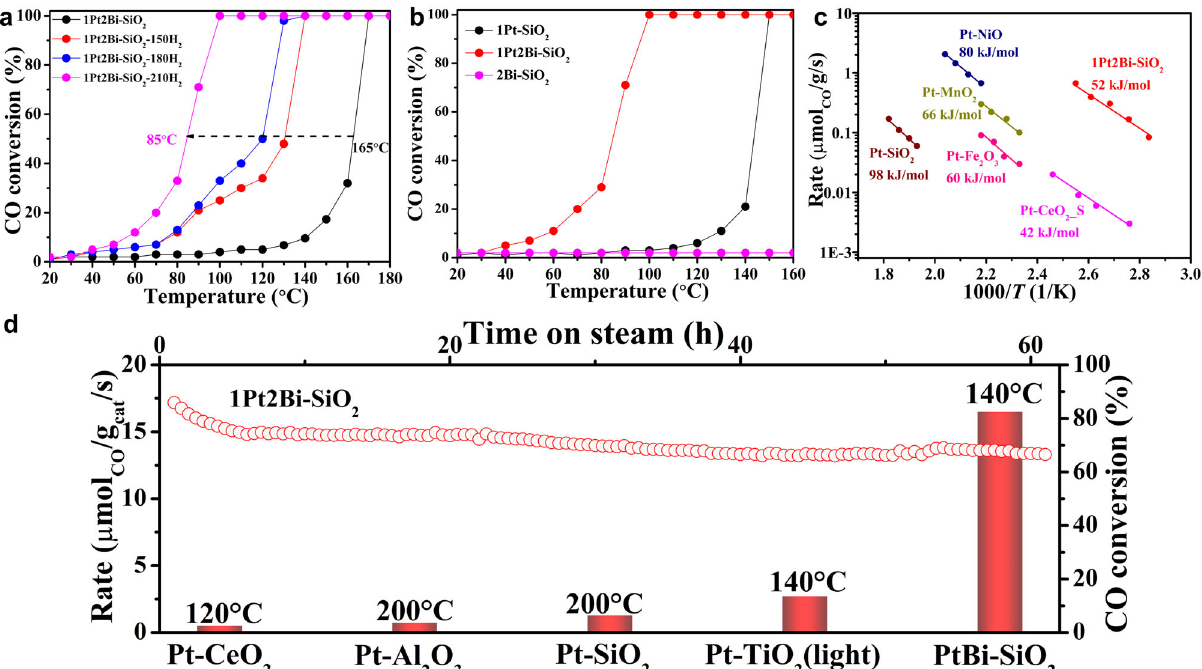
Fig. 3 Catalytic performance of Pt/PtBi – SiO 2 catalysts in CO oxidation. a CO oxidation experiments with different H 2 -pretreatment temperature for 1Pt2Bi-SiO 2 ; b Catalytic CO oxidation light-off performance of different catalysts at a gas hourly space velocity of 134,000 mL g cat – 1 h – 1 in 1 vol.% CO/20 vol.% O 2 /79 vol.% N 2 . Temperature ramp: 2 °C min − 1 ; c Apparent activation energy ( E a ) of various catalysts; d CO oxidation stability test (150 °C, 200,000mL g − 1 h − 1 ) and reaction rate of different